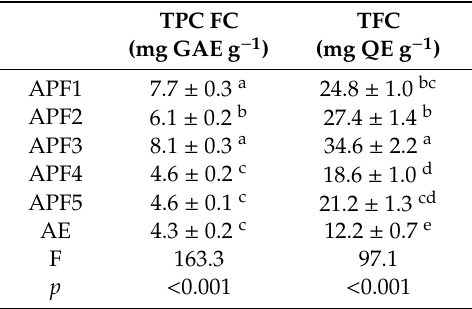
Table 1. Total phenol (TPC) and flavonoid (TFC) content in apple pomace flour (APF) and apple egg (AE) expressed in mg of gallic acid and quercetin equivalents per gram (mg GAE g − 1 and mg QE g − 1 ).